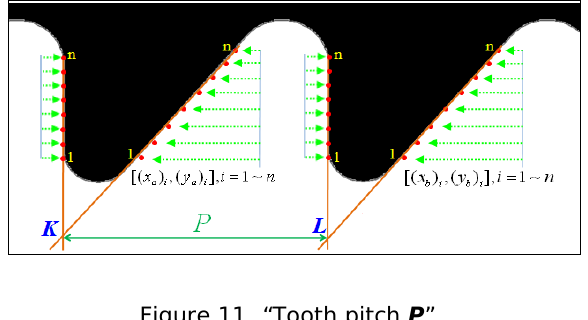
Figure 11. “Tooth pitch P